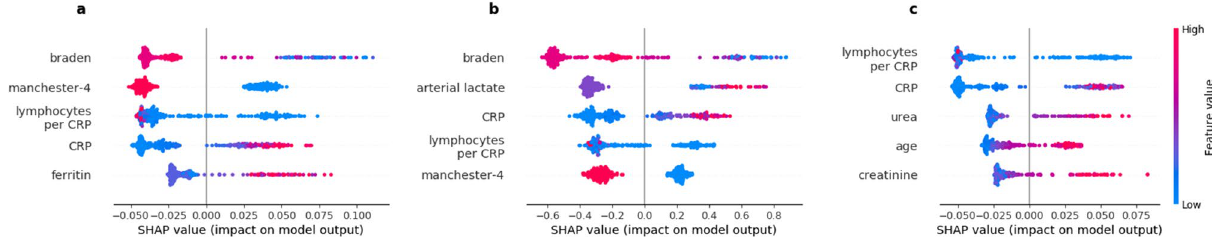
Figure 2. Top five feature contributions to predict severe outcome in the aggregated models, BP Hospital—A Beneficência Portuguesa de São Paulo, Brazil, 2020. ( a ) Combined outcomes (MV + ICU) to predict death ( b ) Combined outcomes (Death + ICU) to predict MV. ( c ) Combined outcomes (Death + MV) to predict